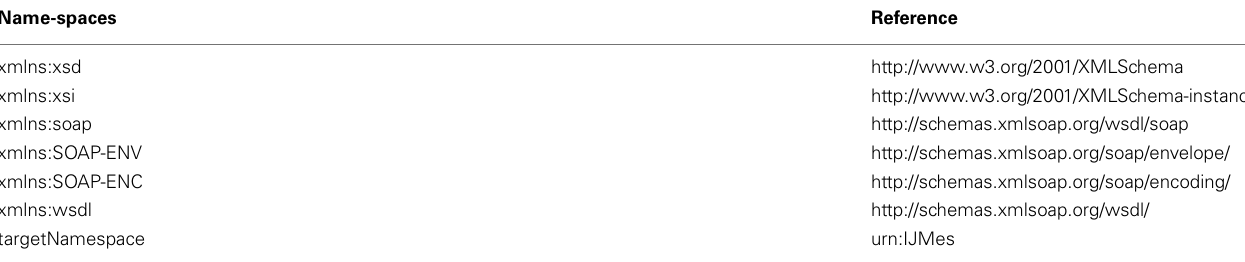
TableA1 | Name-spaces of the web-service.